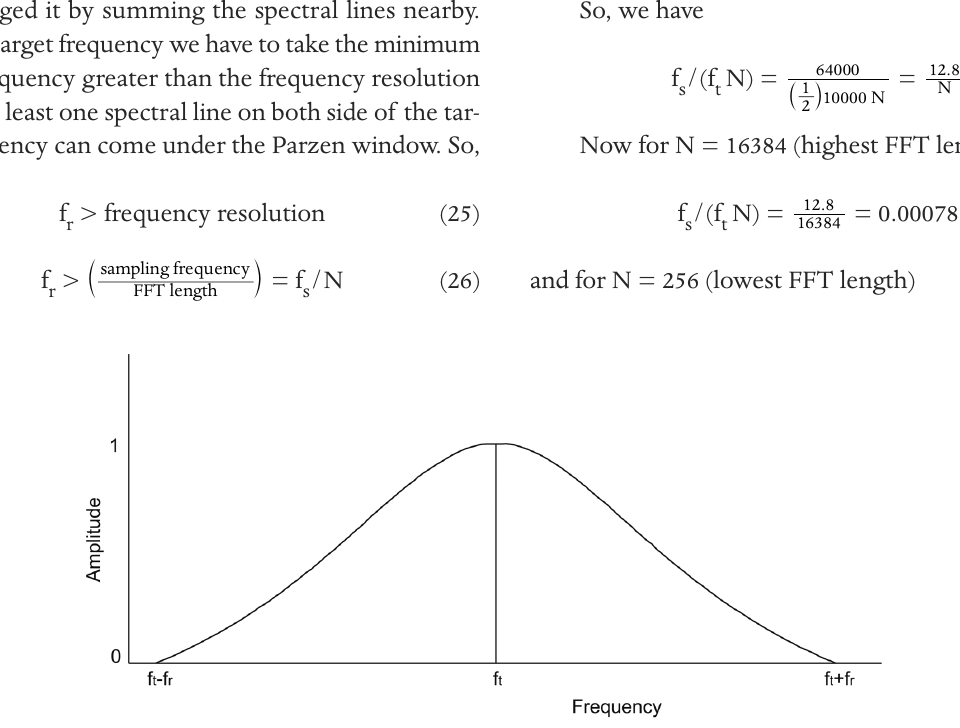
is the radial frequency which determines the value of Parzen r